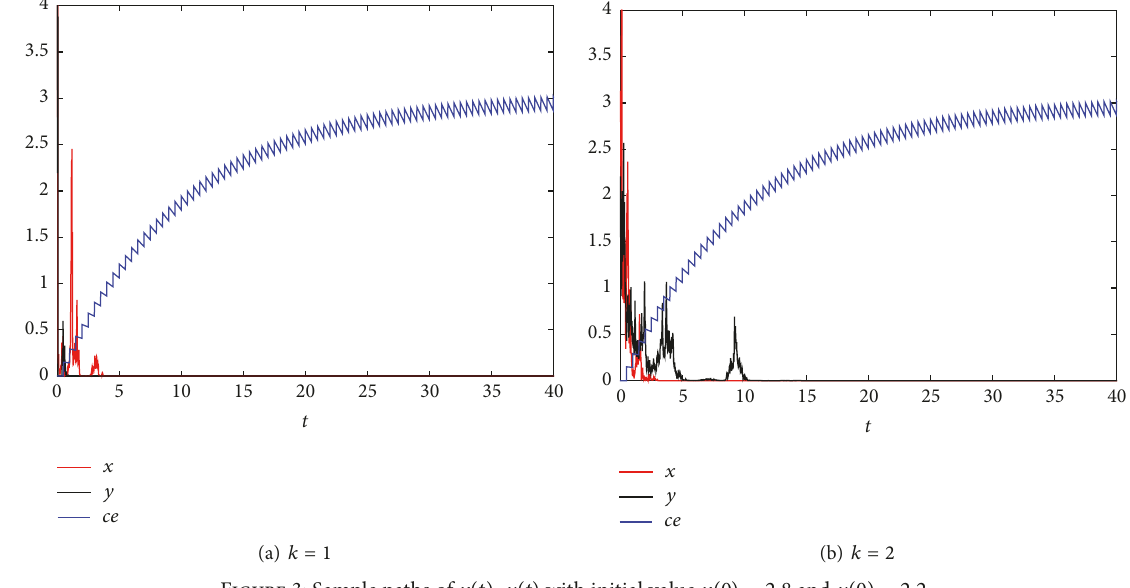
Figure 3: Sample paths of 𝑥(𝑡) , 𝑦(𝑡) with initial value 𝑥(0) = 2.8 and 𝑦(0) = 2.2 .